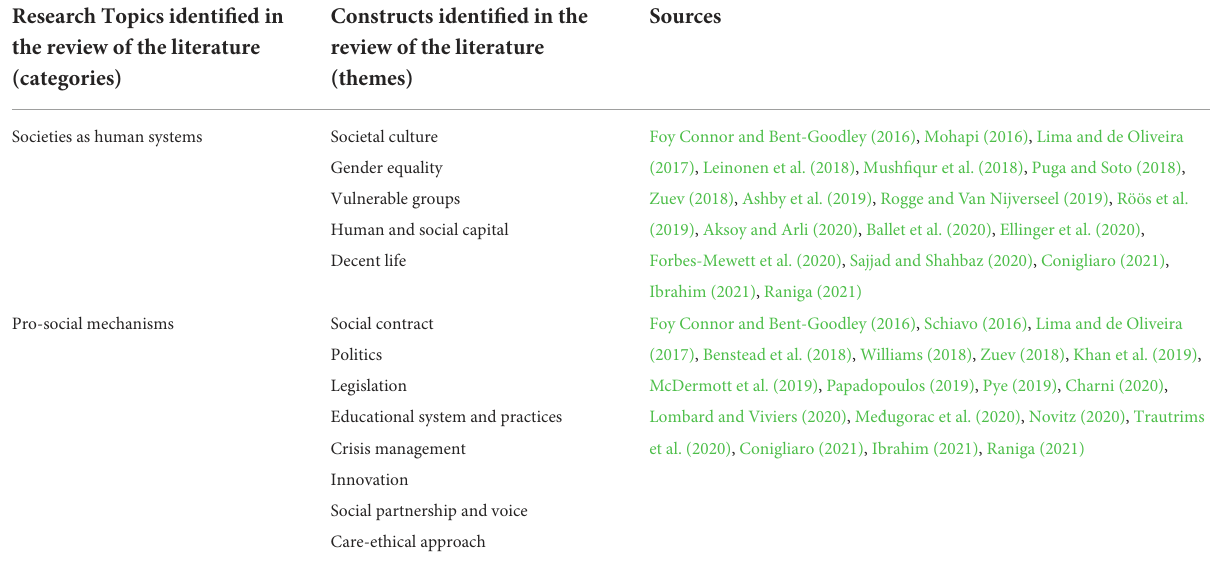
TABLE 5 Society-focused Research Topics and